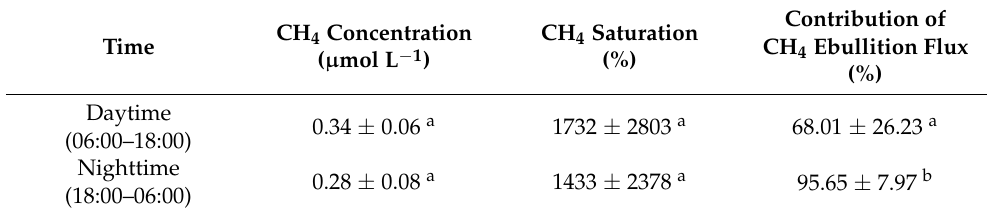
Table 1. Dissolved CH 4 concentration, saturation, and contribution of CH 4 ebullition flux in the Dahejia Reservoir at different